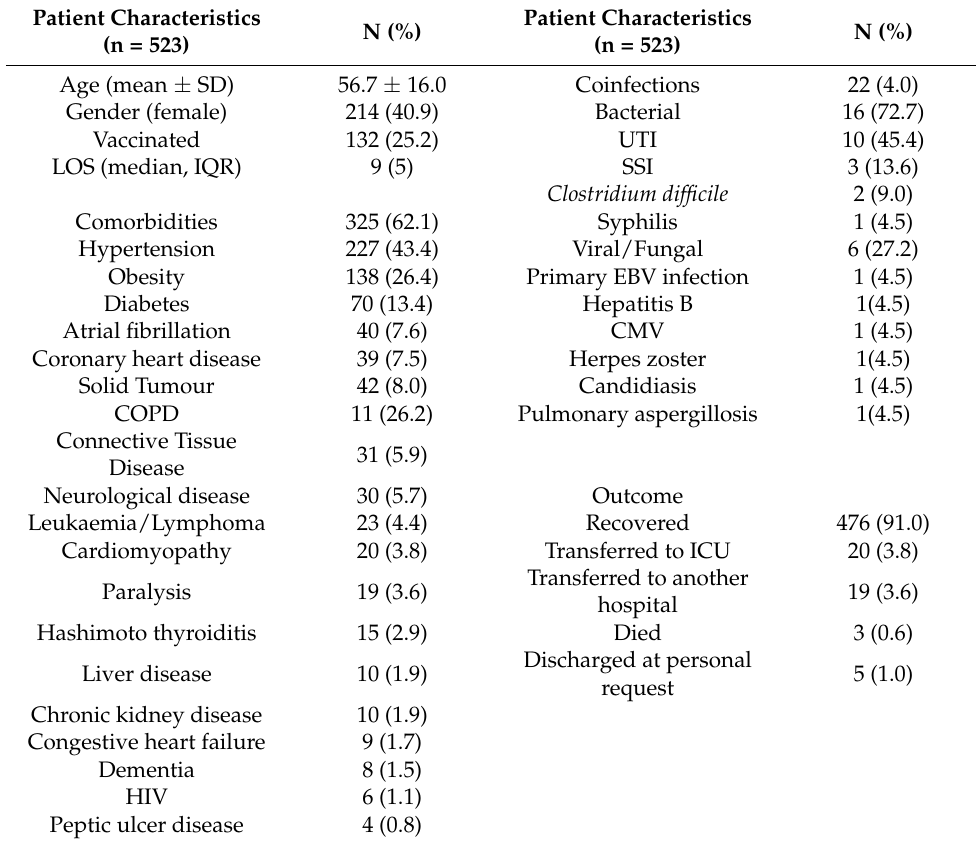
Table 1. Clinical characteristics of study patients with